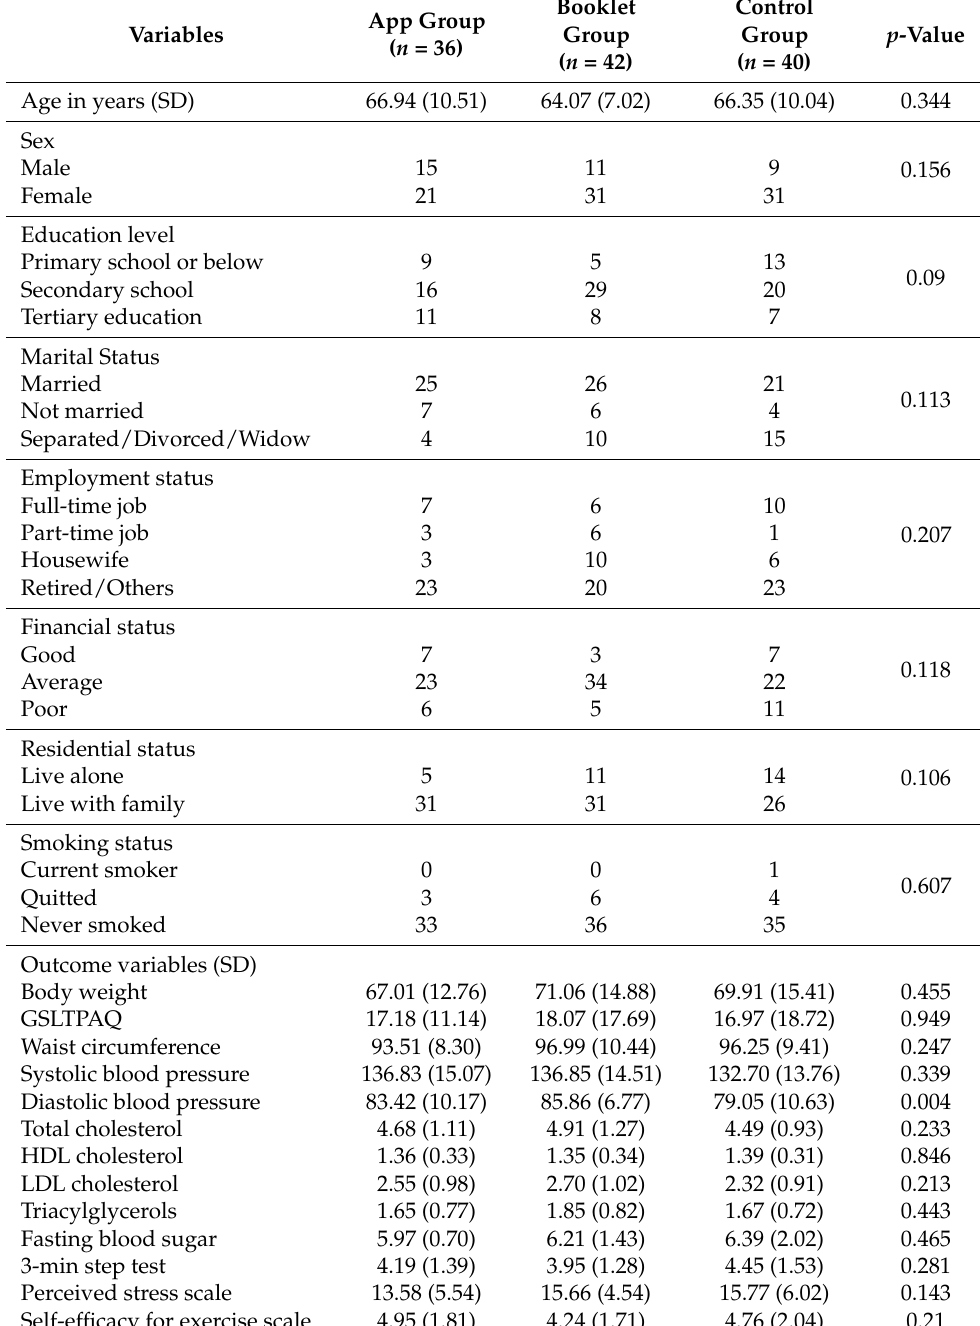
Table 1. Characteristics of participants and outcome variables at